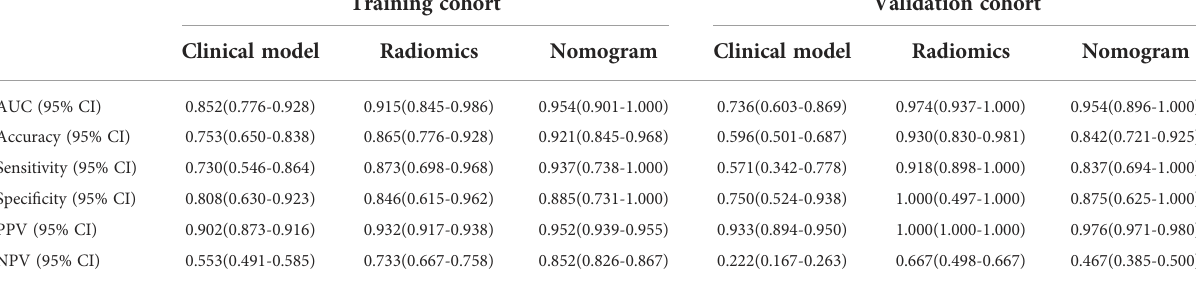
TABLE 2 Diagnostic performance of clinical model, radiomics, and nomogram in differentiating BEOT from